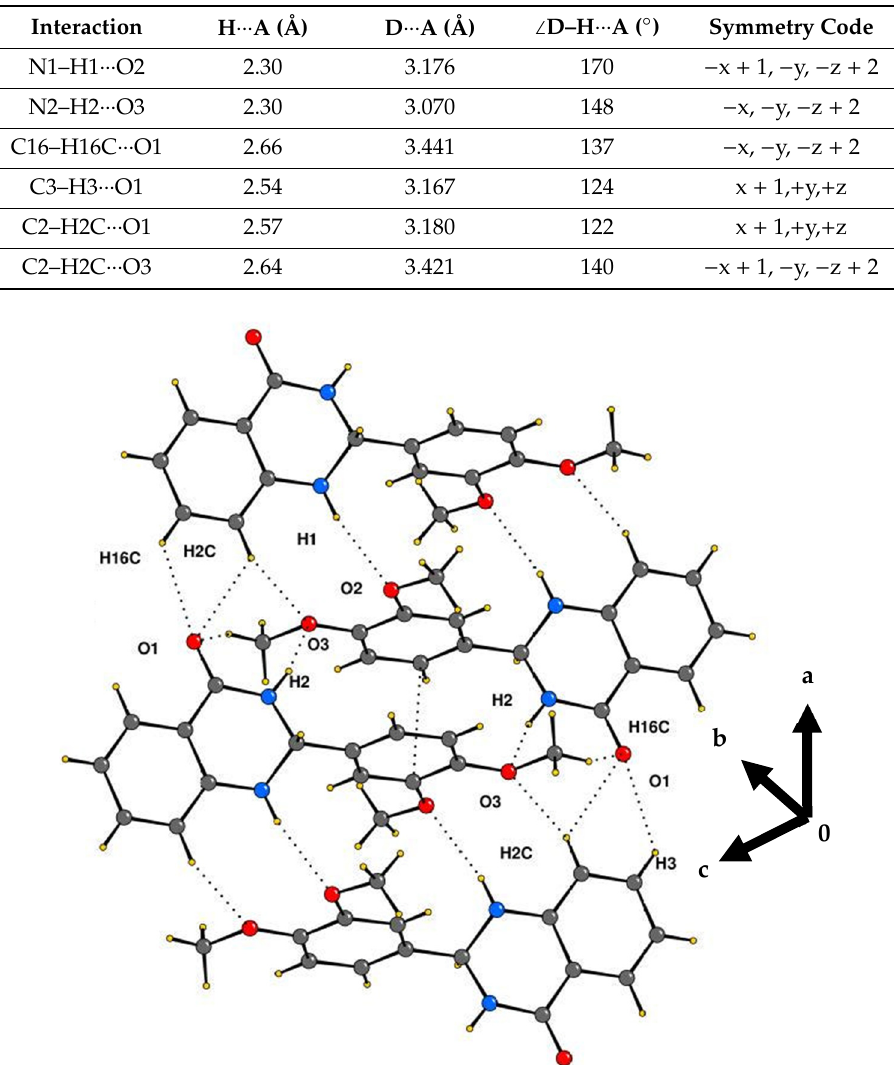
Figure 3. Packing arrangement of molecules in the crystal structure via formation of tetramers involving N–H ∙∙∙ O hydrogen bonds (H-bonds), C–H ∙∙∙ O interactions, and π – π stacking interactions.